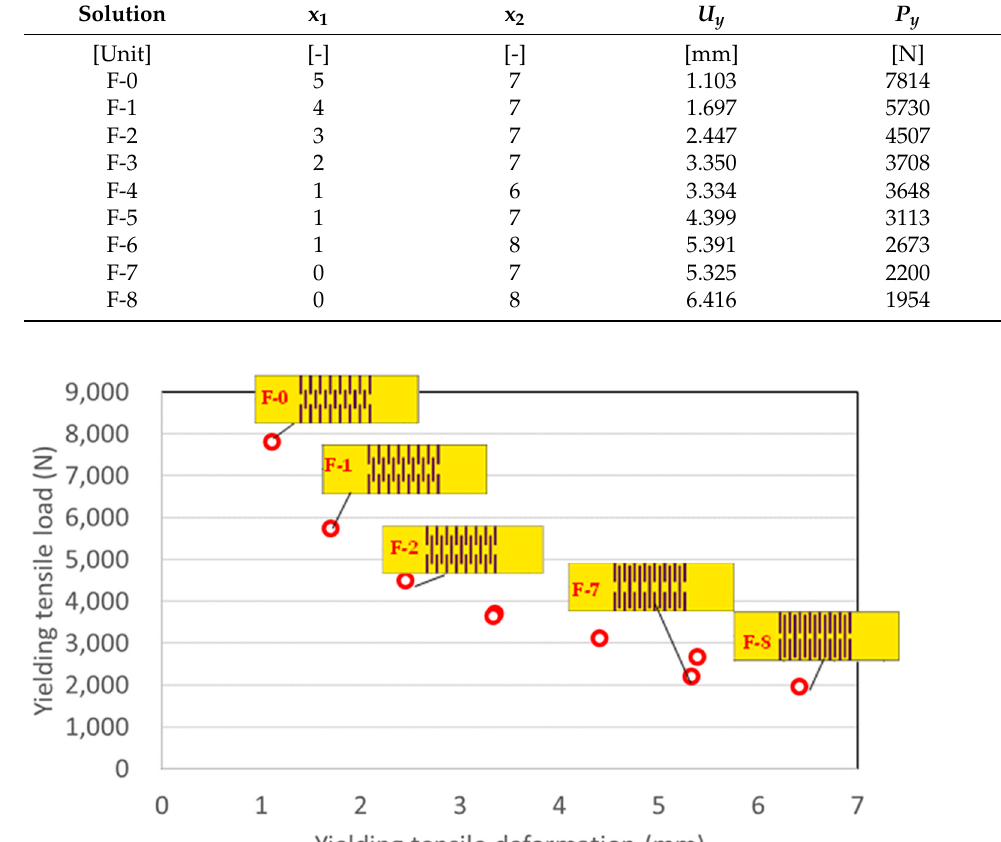
Figure 10. Relationship between tensile yielding deformation and tensile yielding load (2.5 mm grid elements).